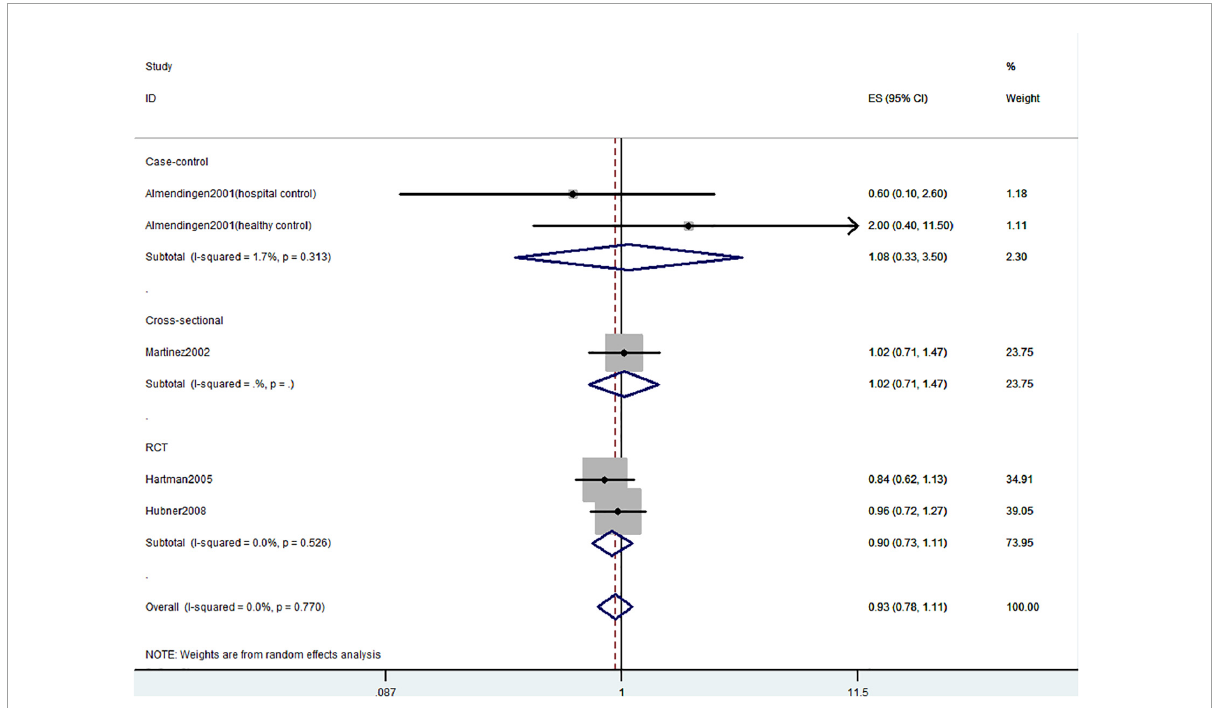
FIGURE5 Random-effects meta-analysis of studies that examined total vitamin D intake and risk of CRC precursors recurrence. ES, effect size.